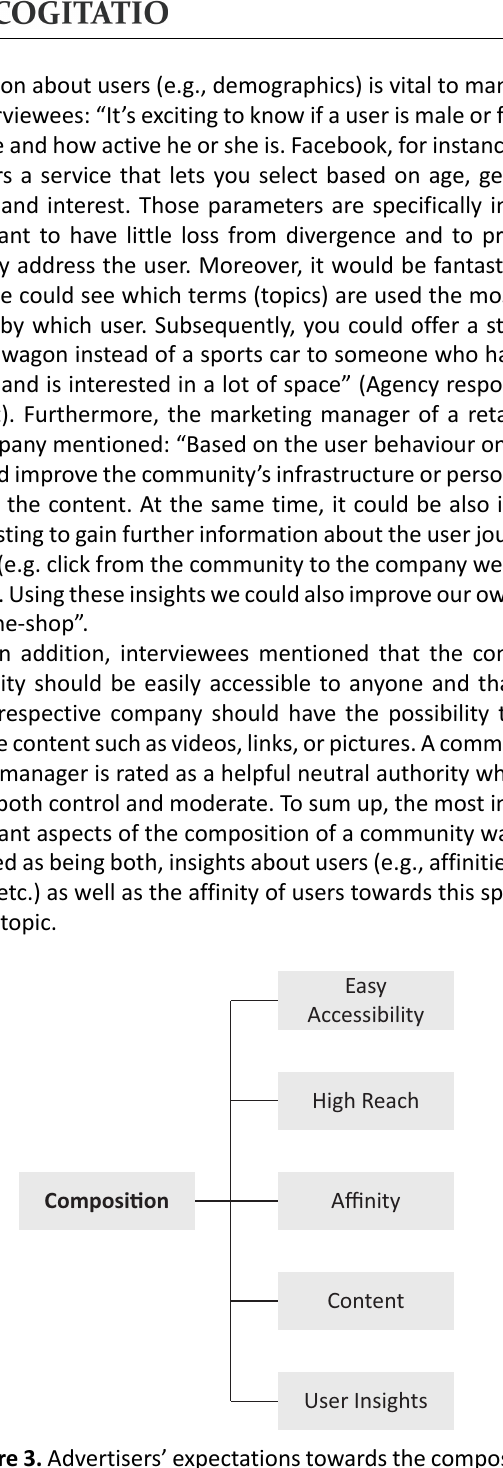
Figure 3. Advertisers’ expectations towards the composi- tion a community.